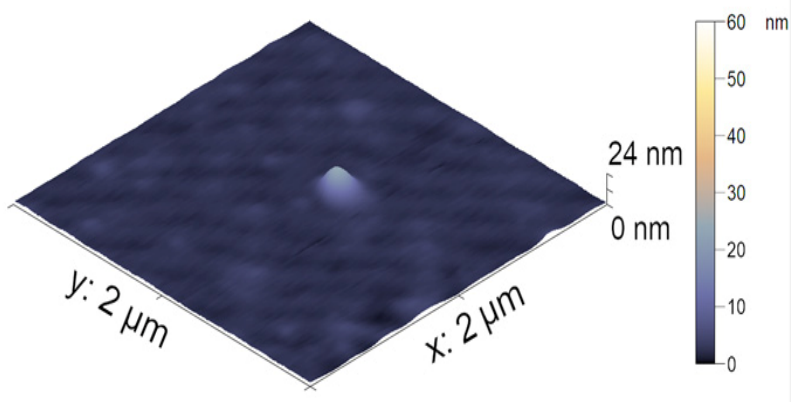
Figure 7. AFM images of the NIPAM ‐ PAA ‐β‐ FeO(OH)–DOX microgel.